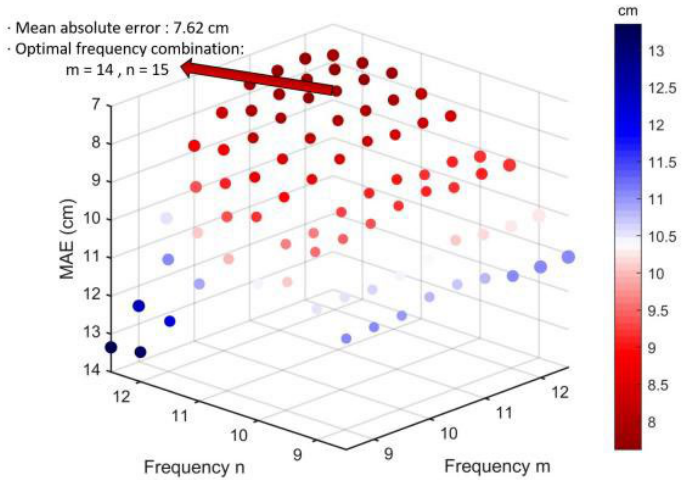
Figure 13. The cumulative absolute error curves under different frequency combinations. Table 6. The value of the cumulative absolute error under different frequency combinations. Frequency n